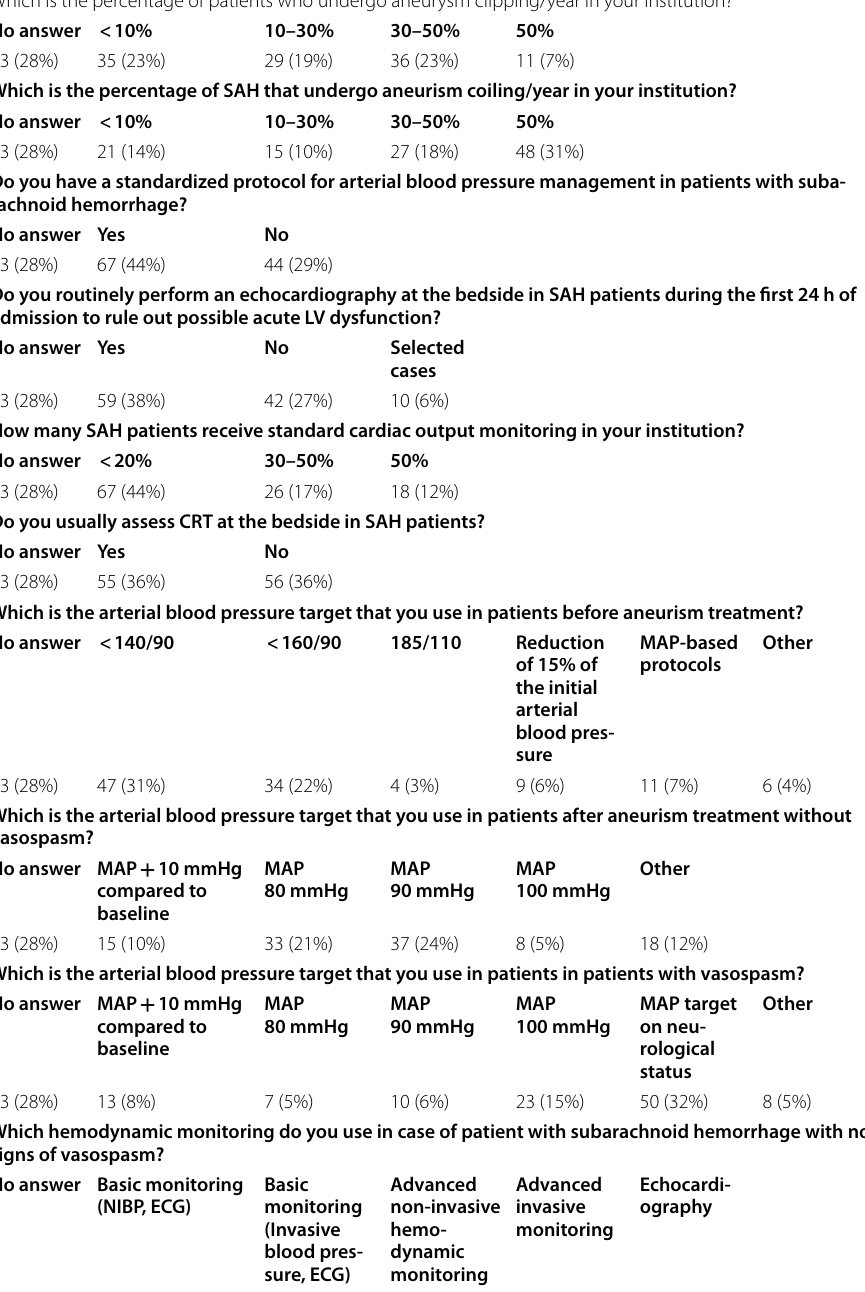
Table 4 Questions and answers on subarachnoid hemorrhage Which is the percentage of patients who undergo aneurysm clipping/year in your